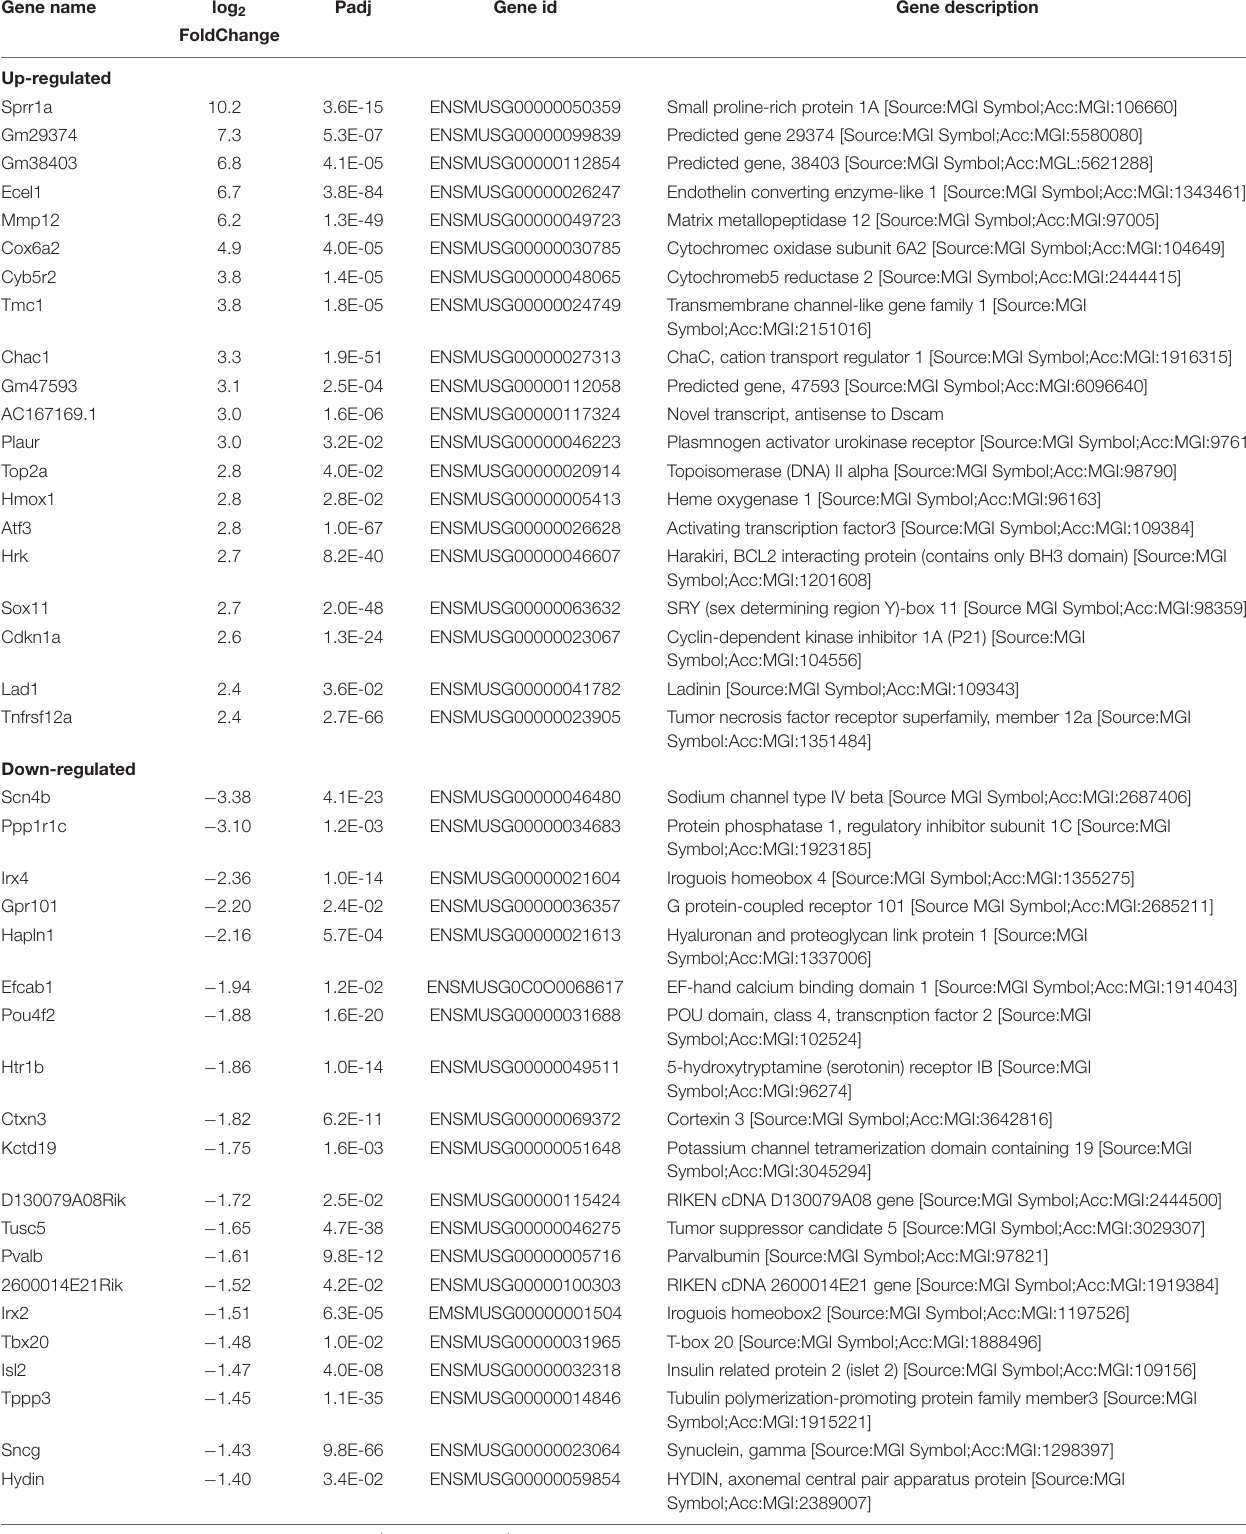
TABLE 1 | Top 20 upregulated and 20 downregulated genes induced by ONC